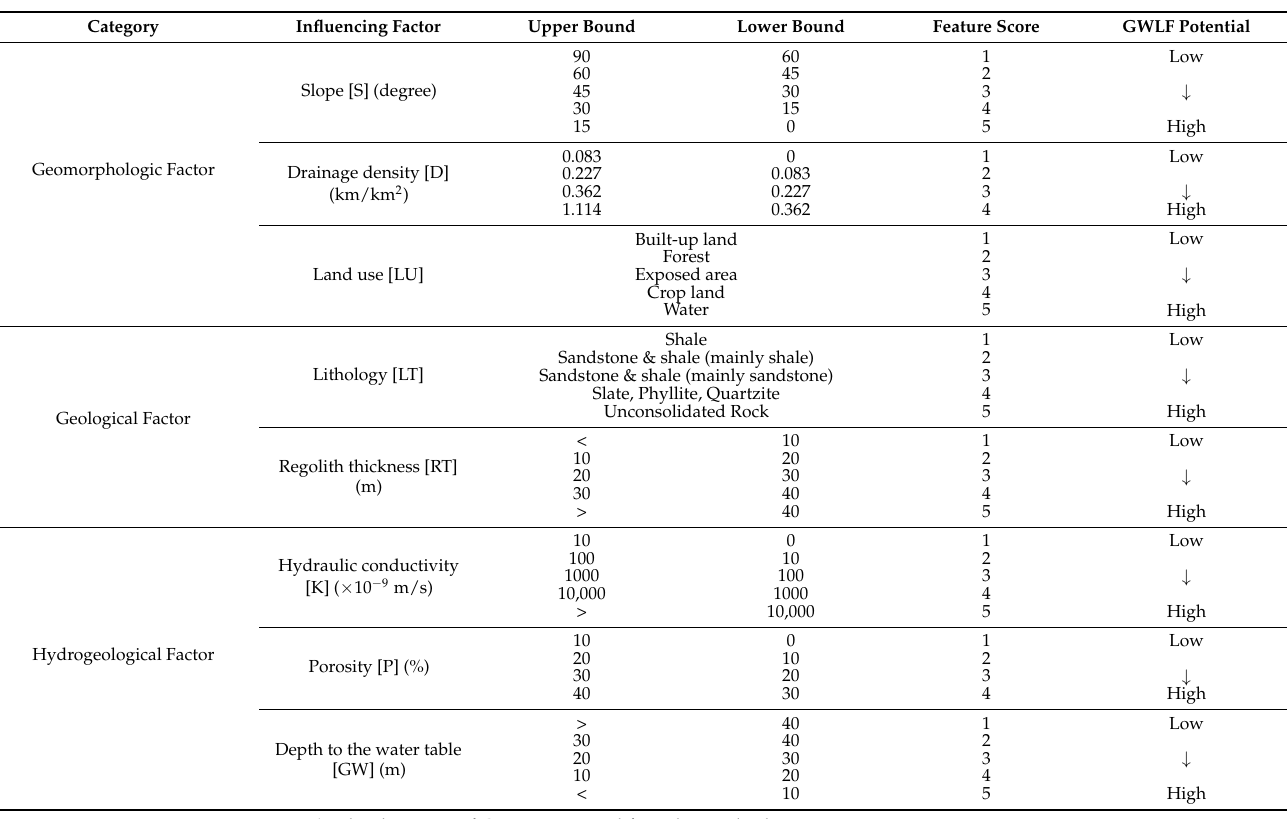
Table 1. Assigned feature scores for different influencing factors associated with groundwater level fluctuation potential.